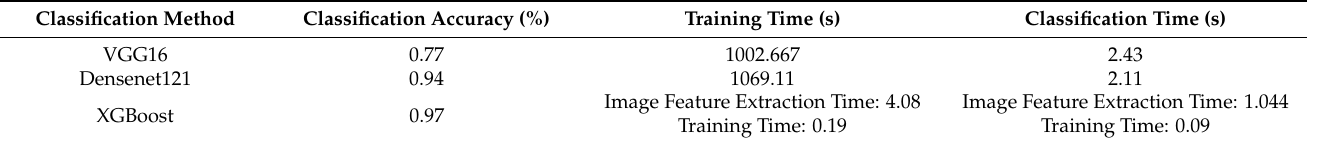
Table 8. Effect of different classification methods for the same test